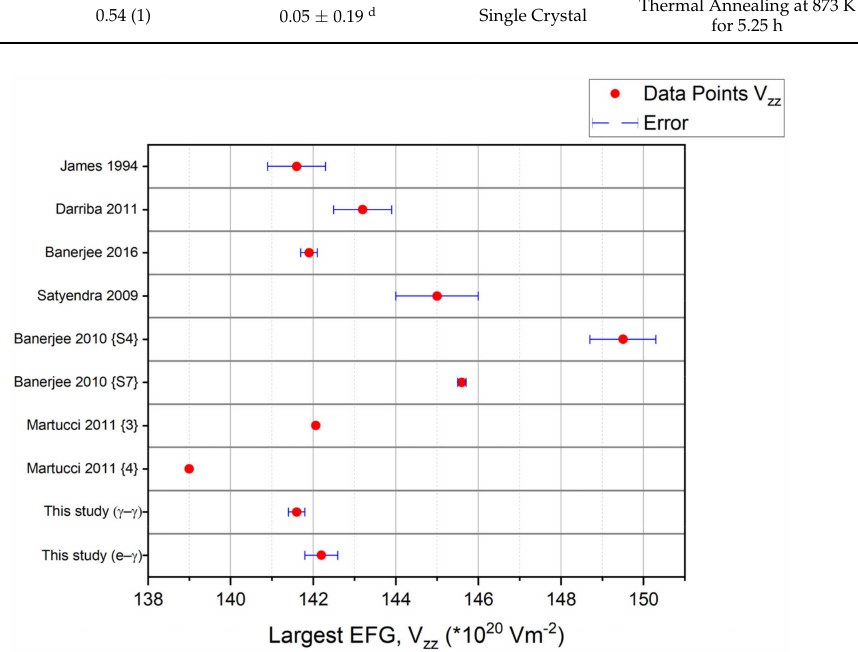
Figure 10. The values of V zz obtained from our γ − γ and e − γ experiments are visually compared with accepted literature values from Table